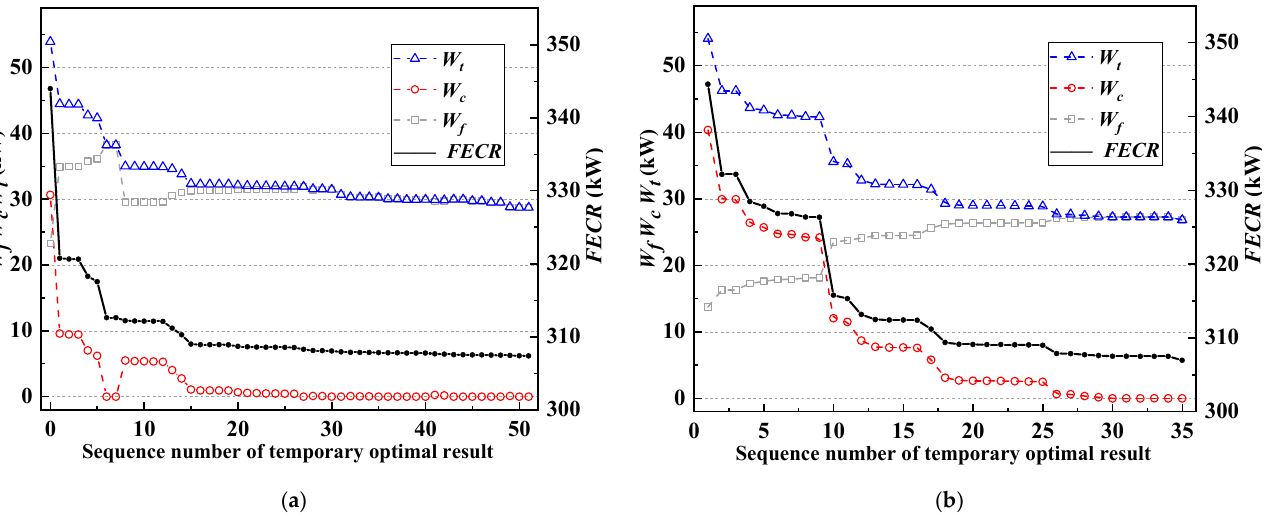
Figure 7. Variation of fan power, compressor power, and turbine power. ( a ) Optimization process of the 1st optimal result; ( b ) Optimization process of the 2nd optimal result.